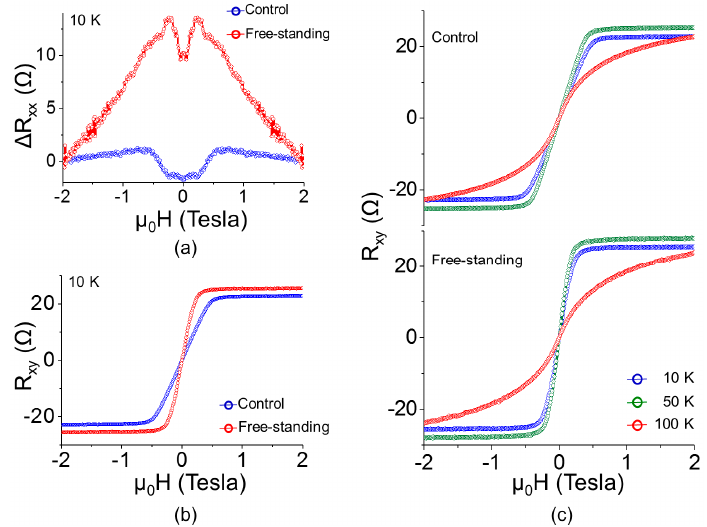
Figure 4 . ( a ) Longitudinal Hall resistance as a function of the applied magnetic field ( Δ R xx vs. H ) at T = 10 K. ( b ) Transverse Hall resistance as a function of the applied magnetic field ( R xy vs. H ) at T = 10 K. ( c ) Field-dependent transverse Hall resistance ( R xy vs. H ) at various temperatures.